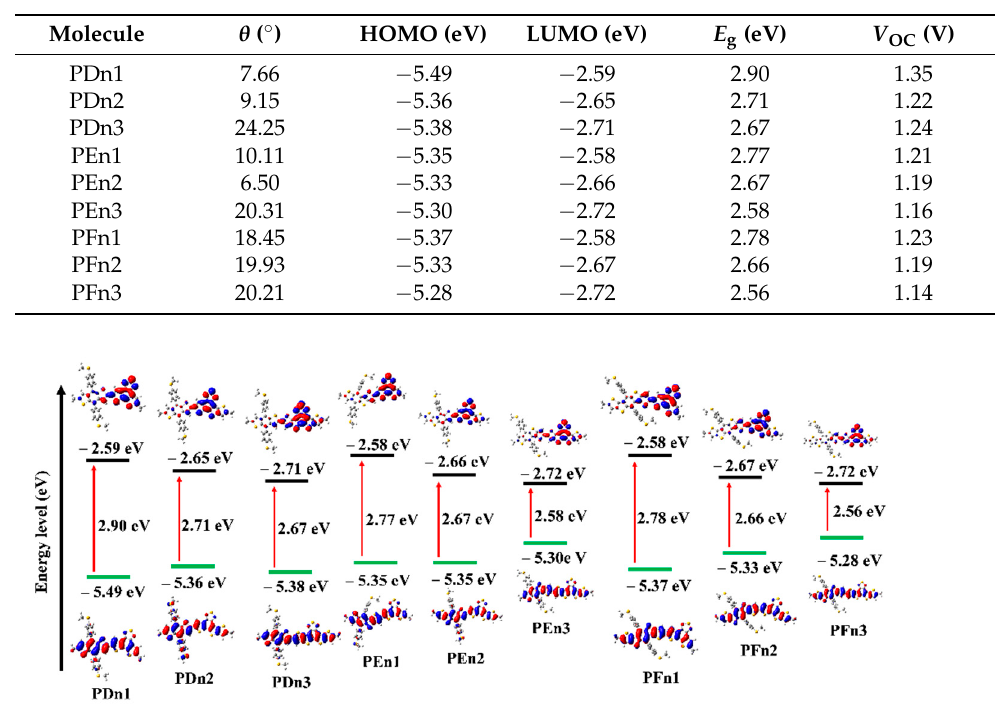
Figure 5. Calculated frontier molecular orbital for all the molecules. The PCE of the PSCs can be calculated by Equation (1)